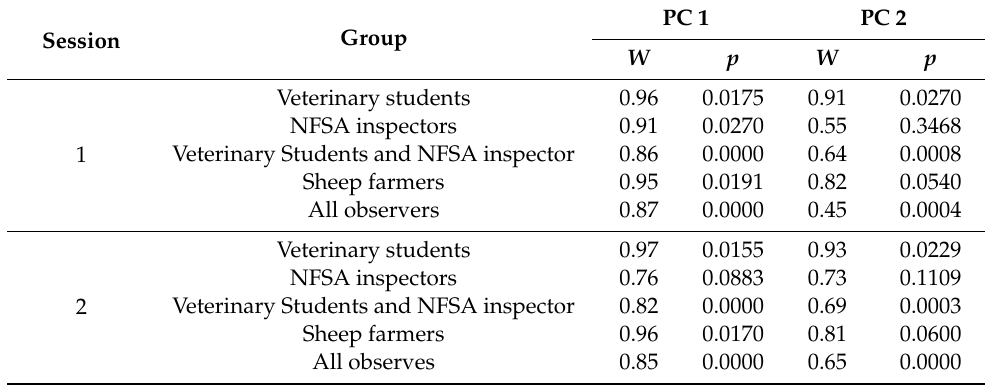
Table 3. Inter-observer agreement given as Kendall’s coefficient of concordance (W) for five groups of observers in two different scoring sessions. The groups were constructed according to background and the level of experience with QBA. PC = principal component .